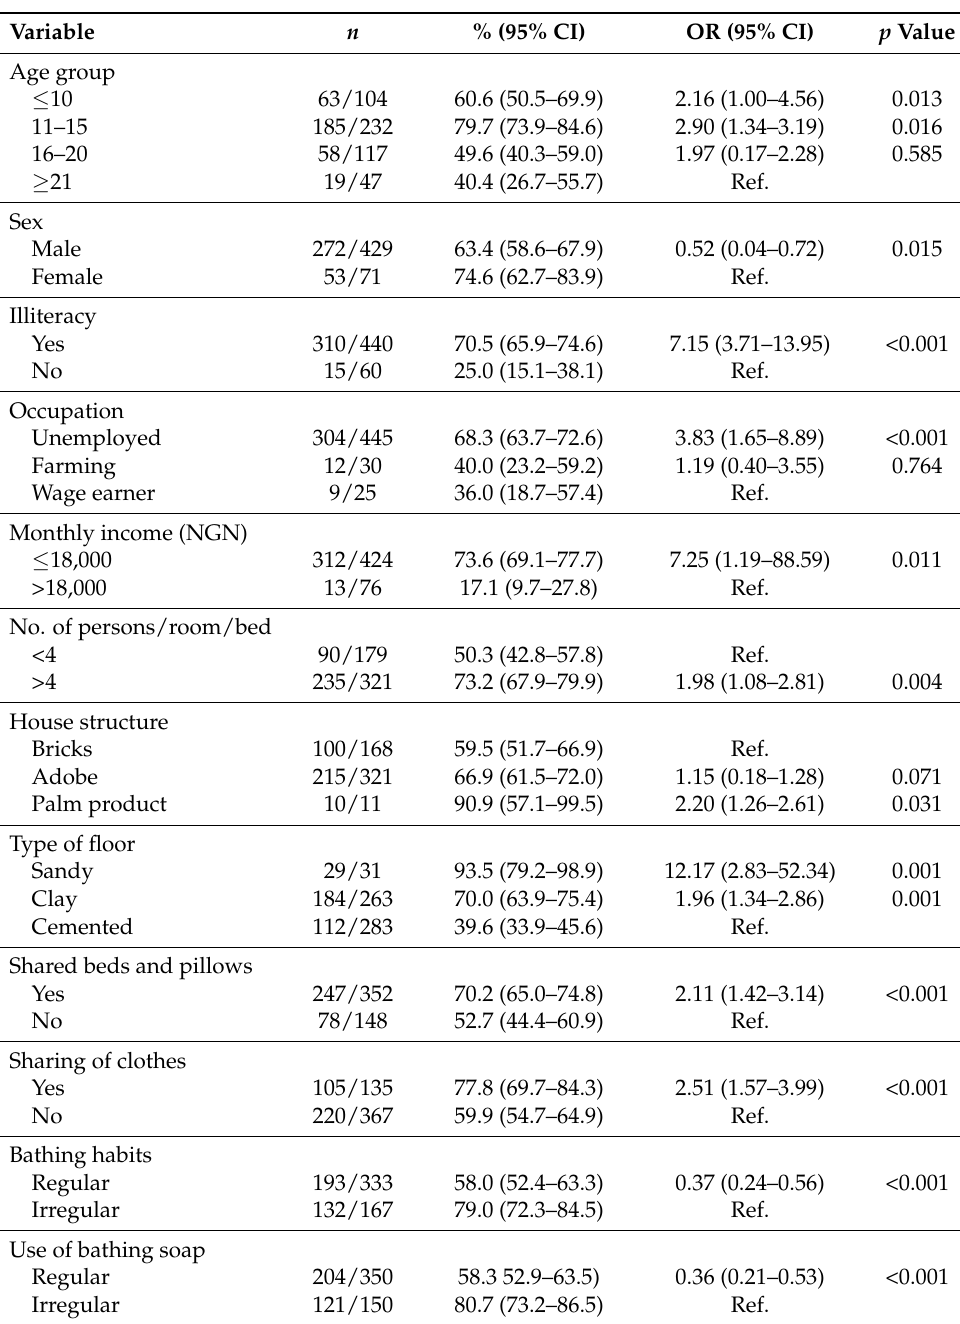
Table 2. Prevalence of scabies and bivariate analysis of socio-demographic and behavioral factors associated with